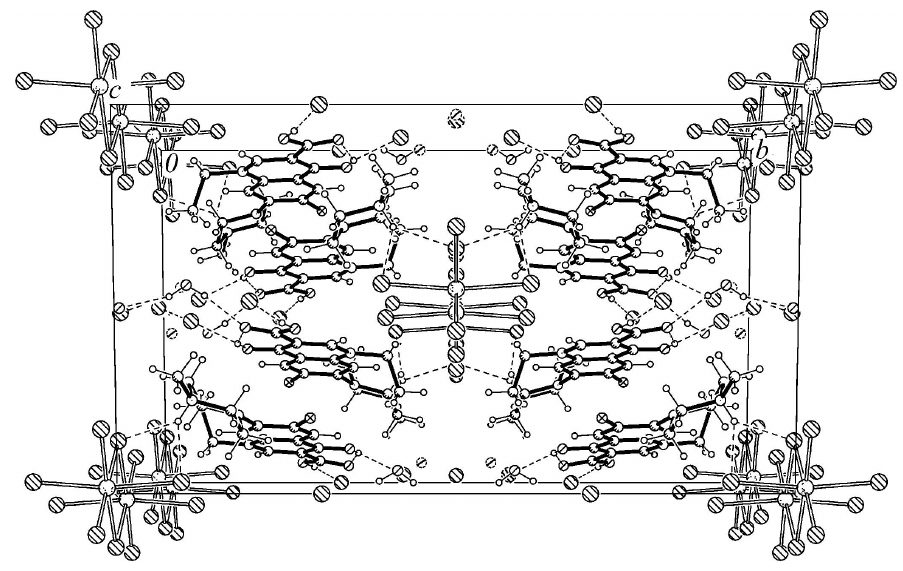
F ] 4- complex, with displacement ellipsoids drawn at the 50% probability level. [Symmetry 2 10